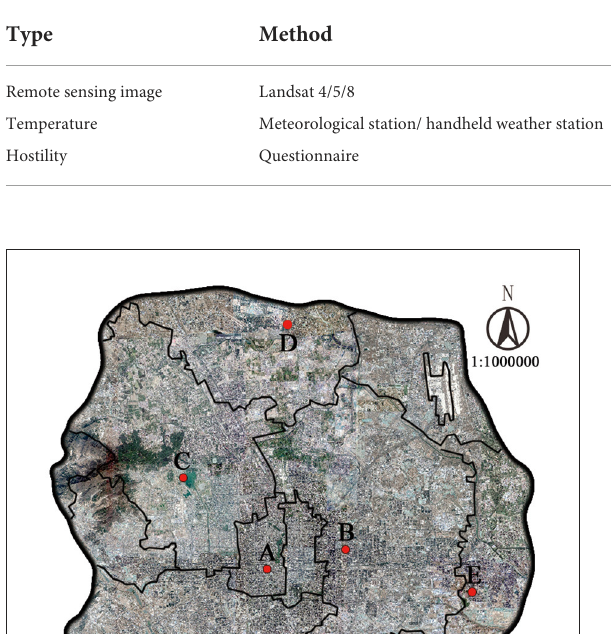
TABLE 1 Data sources.